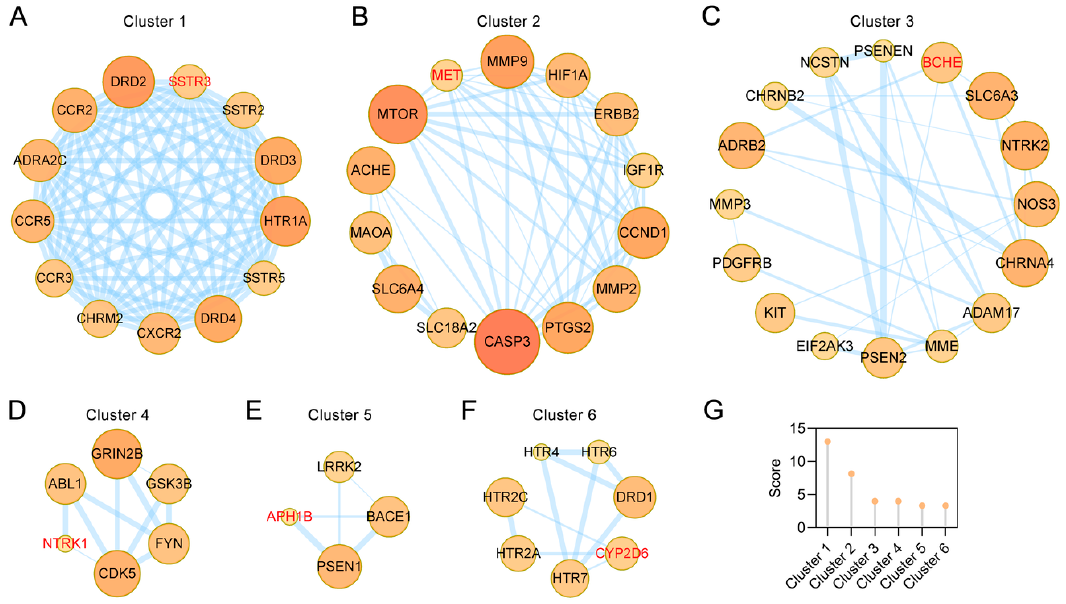
Figure 4. PPI network clusters of common targets of both UR alkaloids and in AD. ( A – F ) Clusters 1 to 6 were found with Molecular Complex Detection (MCODE), which can identify densely connected regions. The seed node of each cluster is indicated by red font. ( G ) Comparison of the MCODE scores of different clusters.